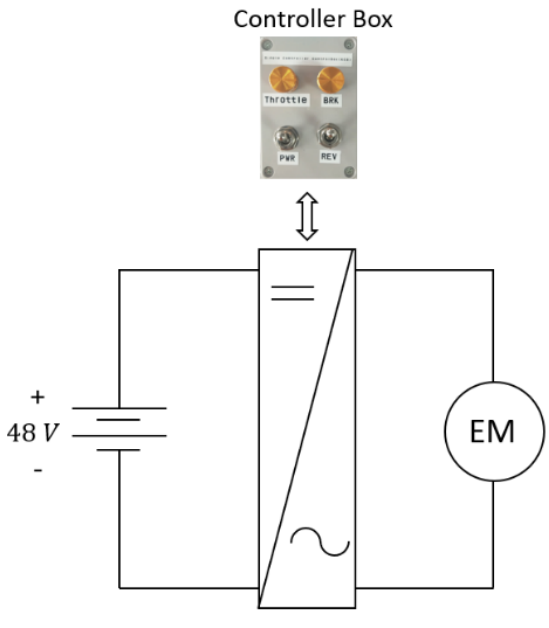
Figure 5. Schematic representation of the electric system. Table 4. Technical data of the electric system.